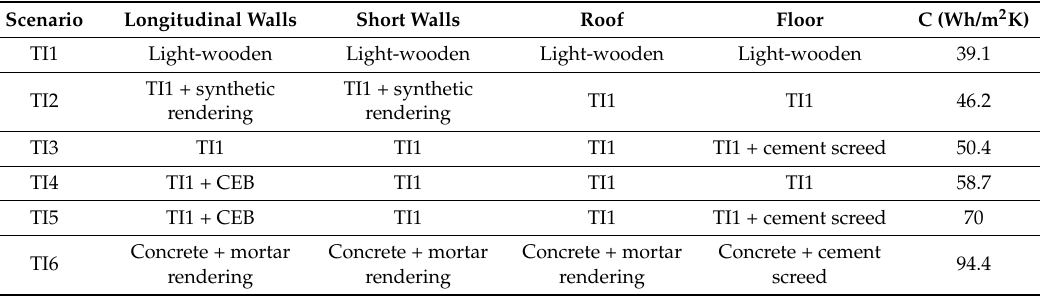
Table 2. Thermal mass scenarios used for the analysis. Calculation followed SIA380/1, based on the heat capacity of the room that depends from the thermal properties of each surface that delimits the considered room.